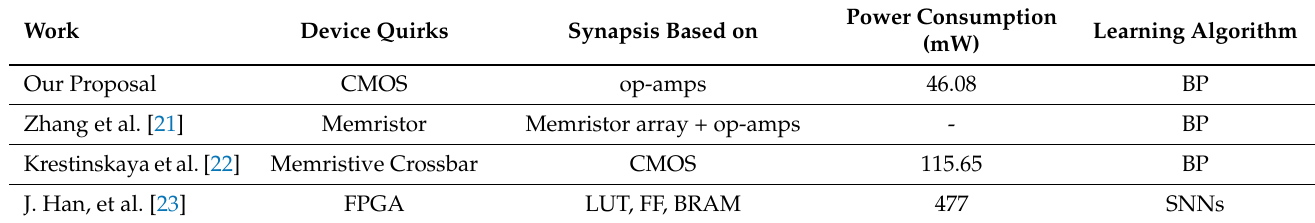
Table 8. Comparison between our proposal and related